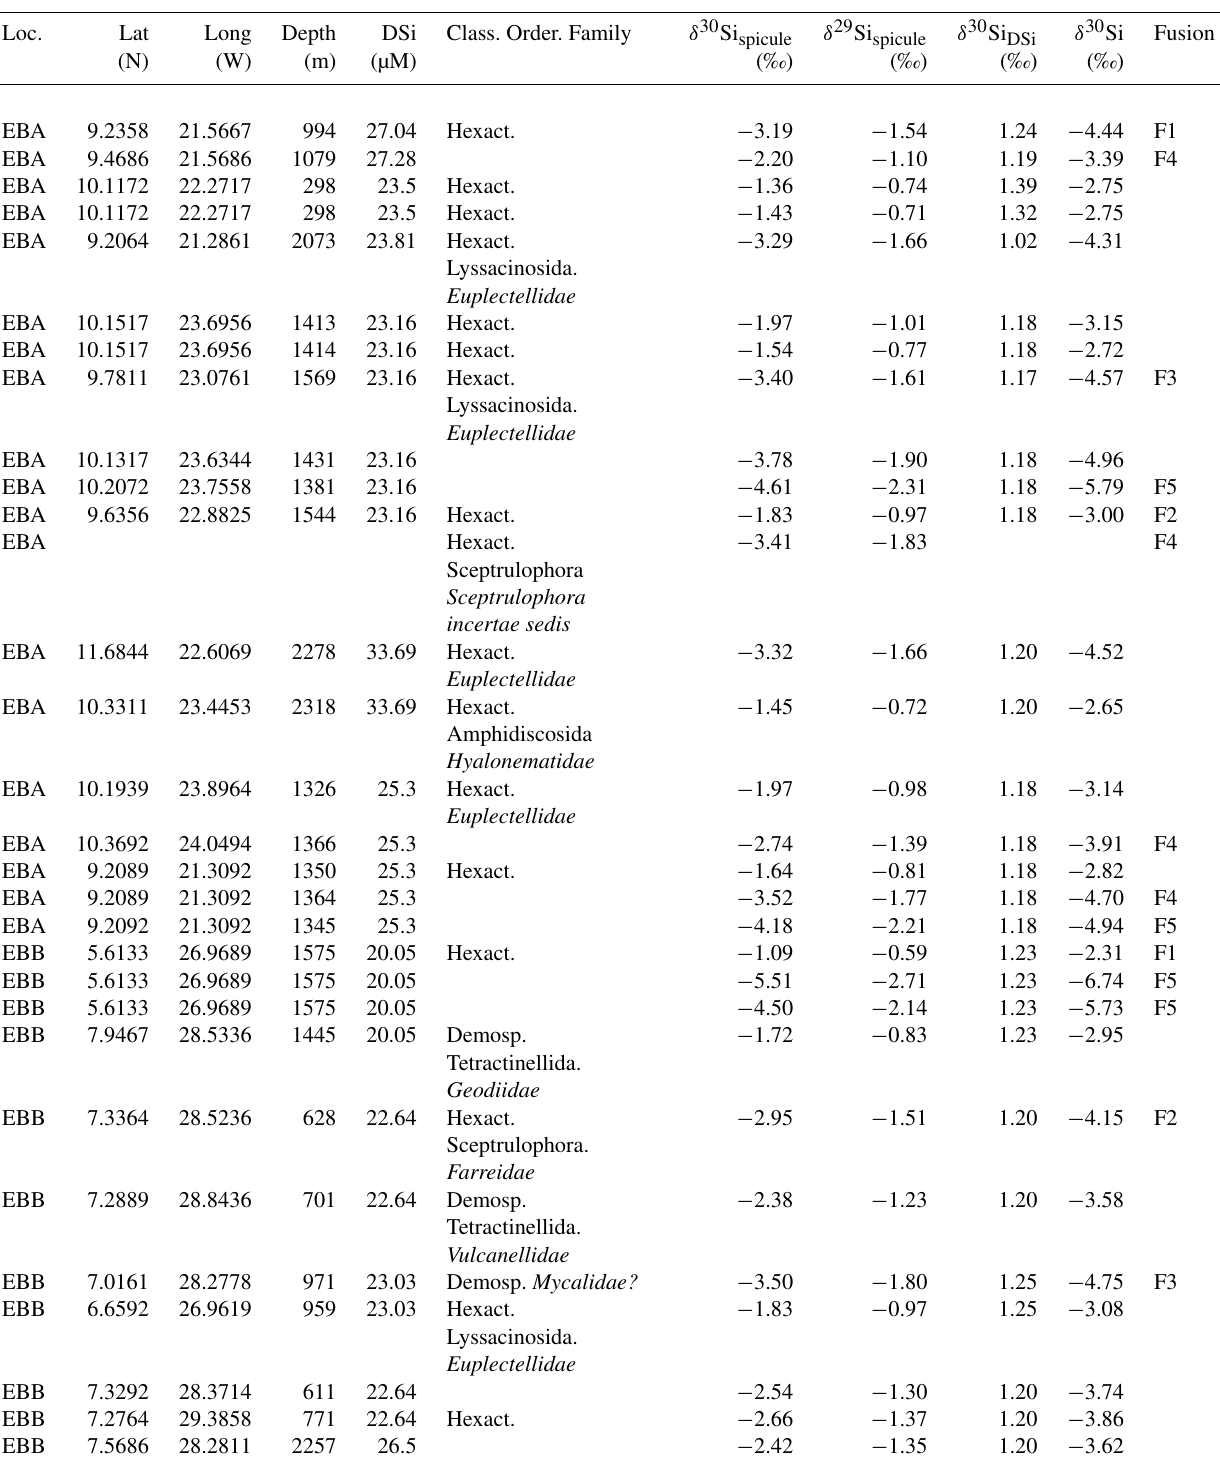
Table A1. Location details and isotopic signature ( δ 30 Si) and apparent Si isotopic fractionation ( δ 30 Si) of deep sea sponges from the equatorial Atlantic. Taxonomic rank of sample starts with the class (Hexact. for Hexactinellida and Demosp. for Demospongiae), the order and finally the family. δ 30 Si spicule and δ 29 Si spicule are the Si isotopic signatures of the spicules, δ 30 Si DSi is the Si isotopic signature of seawater, δ 30 Si is the apparent Si isotopic fractionation by deep sea sponges and fusion is the fusion stage defined from SEM images (see Table 1 for details). Reproducibility, 2SD, is based upon measurements of standards (see Sect. 2.3) and corresponds to 0.13‰ for δ 30 Si spicule , 0.11‰ for δ 30 Si DSi and 0.17‰ for δ 30 Si.